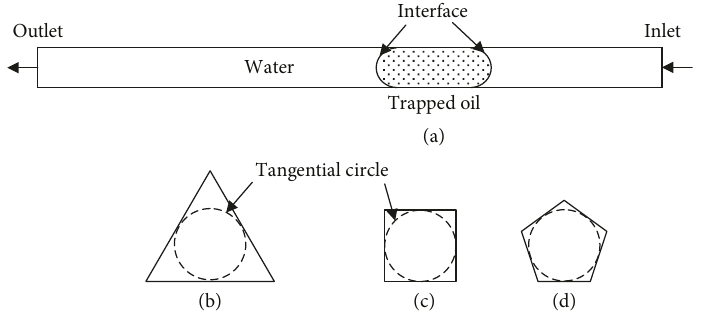
Figure 2: Modeling of the fl ow in capillaries: (a) side view of oil trapped in a capillary, (b) equilateral triangle cross section, (c) quadrilateral cross section, and (d) pentagon cross